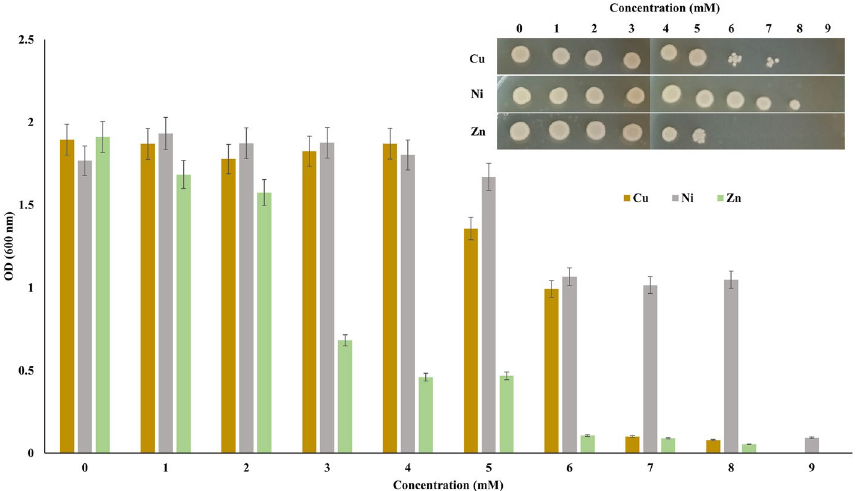
Figure 2. Evaluation of heavy metal tolerance of A. sobria . A. sobria was grown in nutrient broth (NB) supplemented with different concentrations of Cu, Ni, and Zn. Insets: 5 µL broth culture of A. sobria was spotted on NA plates.